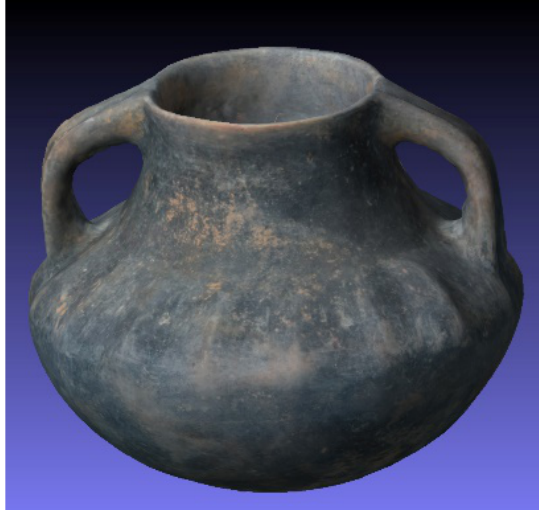
Fig. 10 Model exported from Photoscan in OBJ with texture and imported in Meshlab for visualization and X3D production.